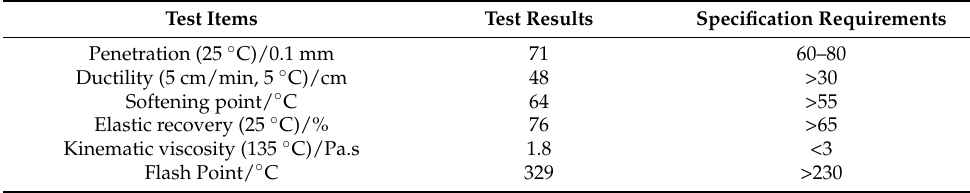
Table 1. Technical performance of the asphalt binder.